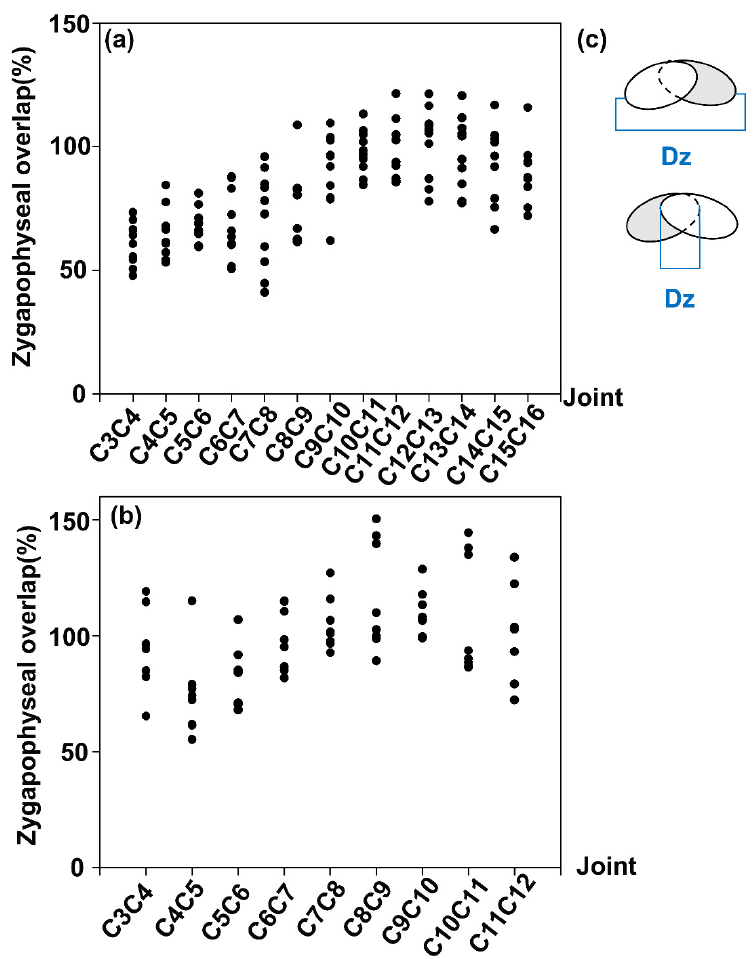
Figure 5. Schematic diagram of the vertebral Zygapophyseal overlaps in ( a ) geese and ( b ) ducks; ( c ) Zygapophyseal overlap diagram.